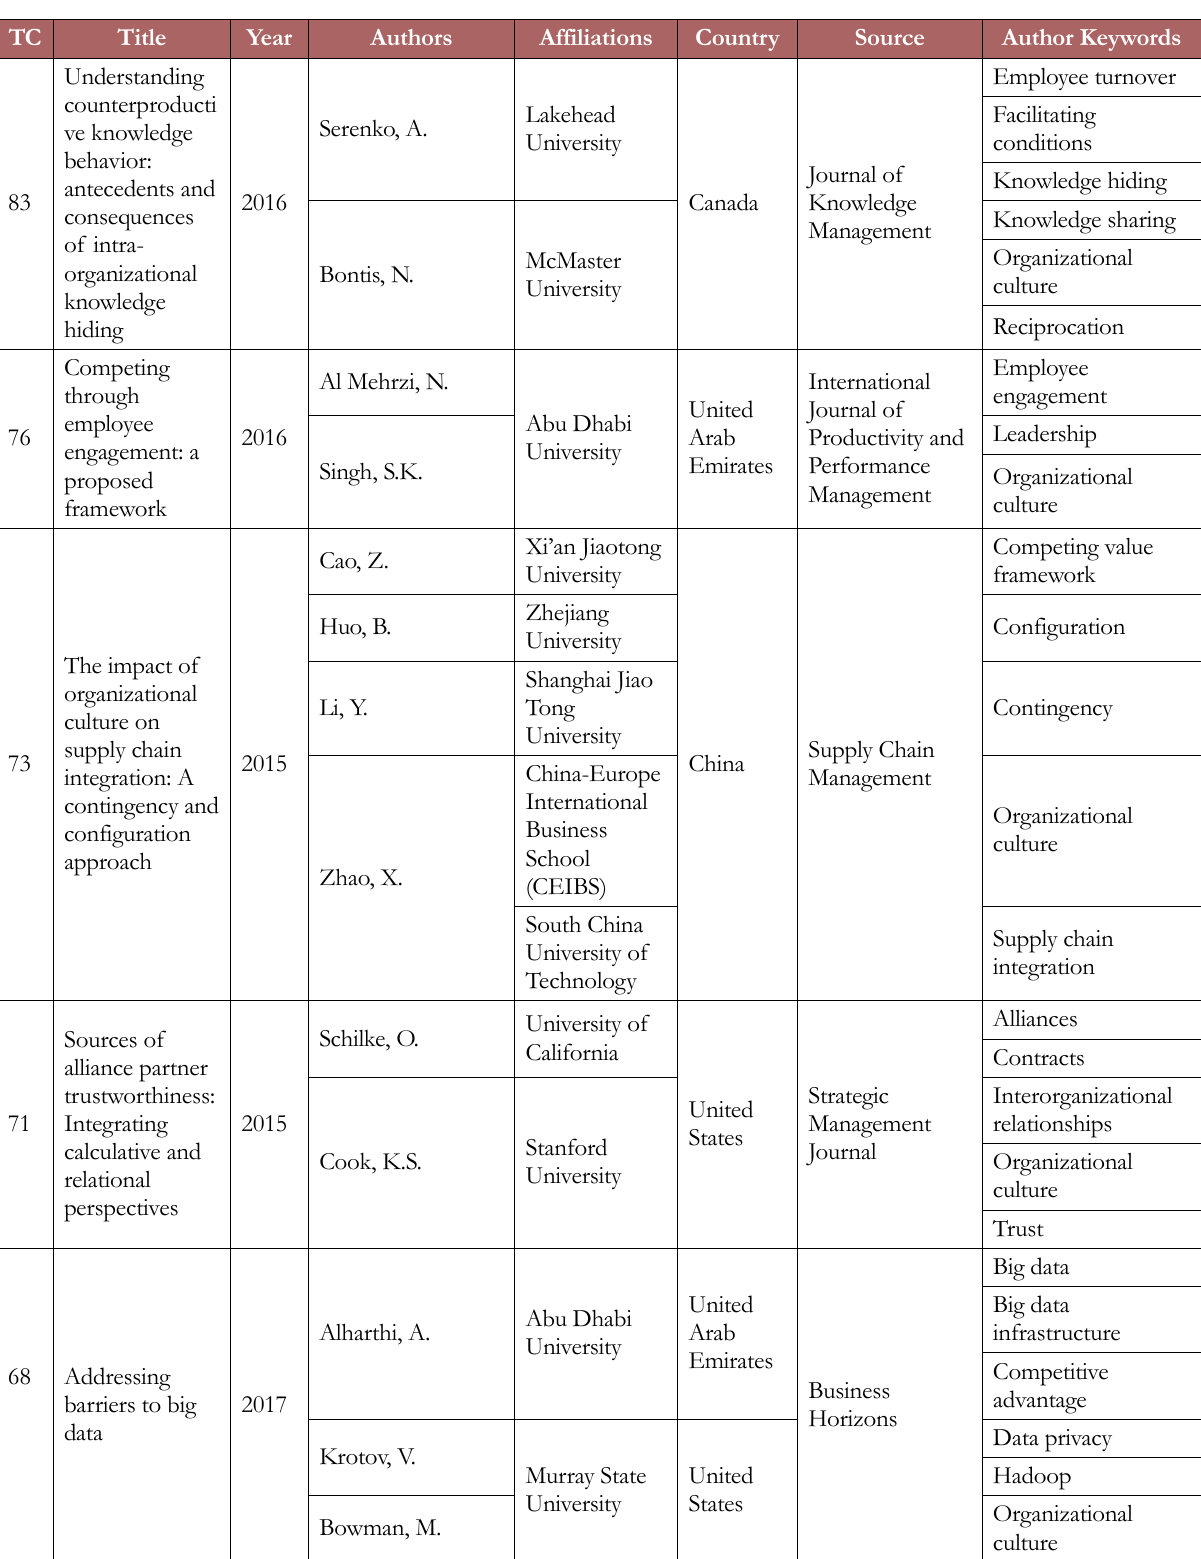
Table 3. The ten most cited documents in the period from 2015 to 17 th September 2020